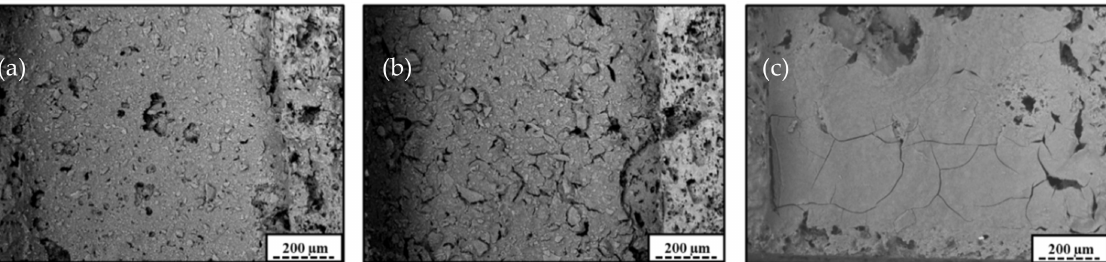
Figure 16. Pictures of dried coatings; ( a ) sample H, ( b ) cracks on sample H coating, ( c ) cracks on sample A